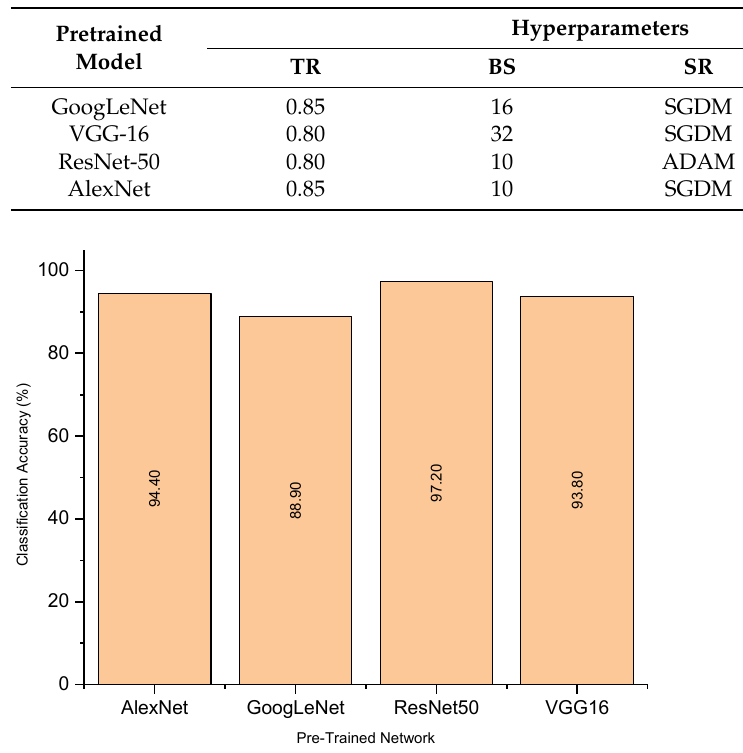
Table 3. Evaluation metrics for the pretrained networks. Pretrained Network